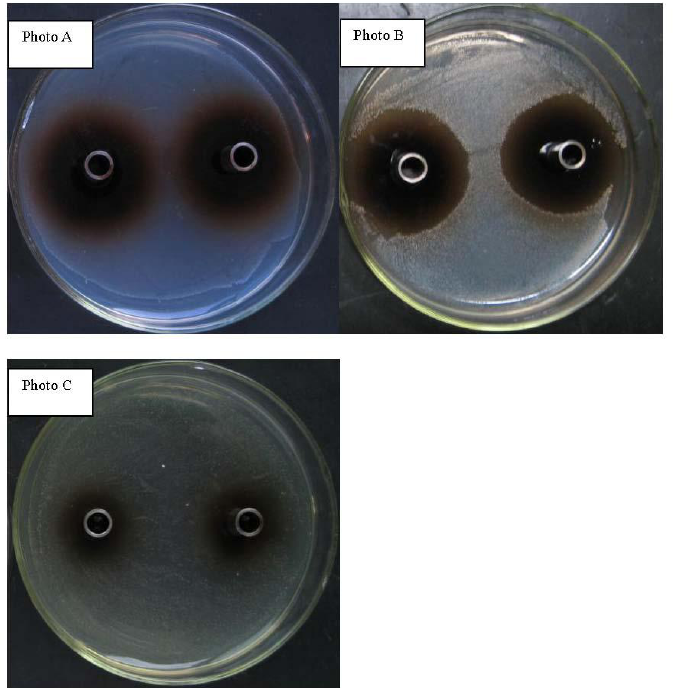
Figure 1. Photo of bacteriostatic activities of Forsythia suspensa extract on the Escherichia coli K88, Staphylococcus aureus , and Salmonella . Concentration of FSE was 200 mg/ml, photo A was for Escherichia coli K88, photo B was for Staphylococcus aureus , photo C was for Salmonella